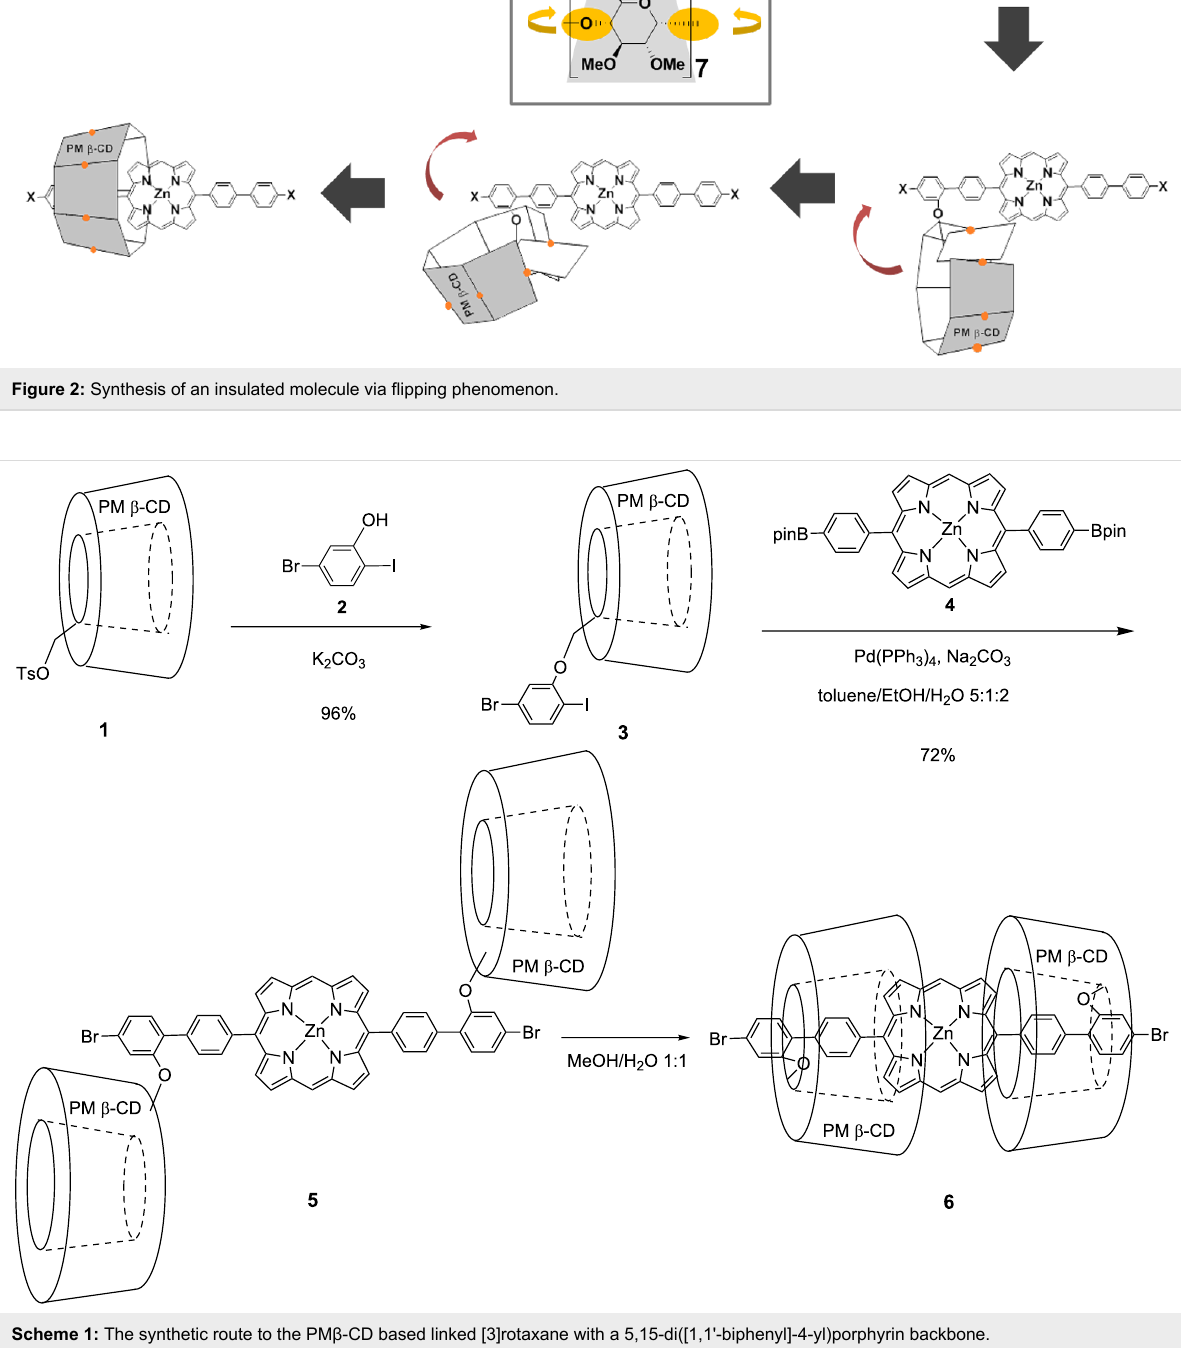
Scheme 1: The synthetic route to the PM β -CD based linked [3]rotaxane with a 5,15-di([1,1'-biphenyl]-4-yl)porphyrin